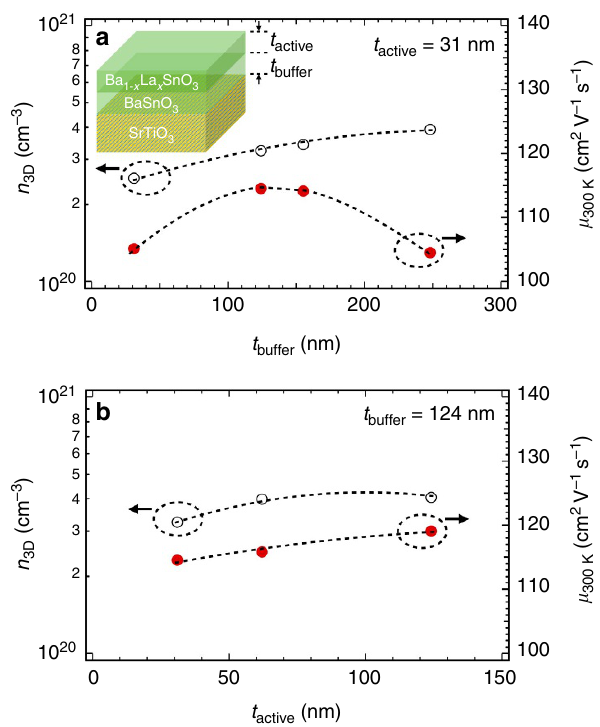
Figure 1 | Effect of buffer and active layer thicknesses on room temperature carrier density and mobility. Variation of n 3D (black open circles) and m 300K (red solid circles) in doped BaSnO 3 films as a function of ( a ) t buffer for fixed t active ¼ 31nm, and ( b ) t active for fixed t buffer ¼ 124nm. Inset shows a schematic of the